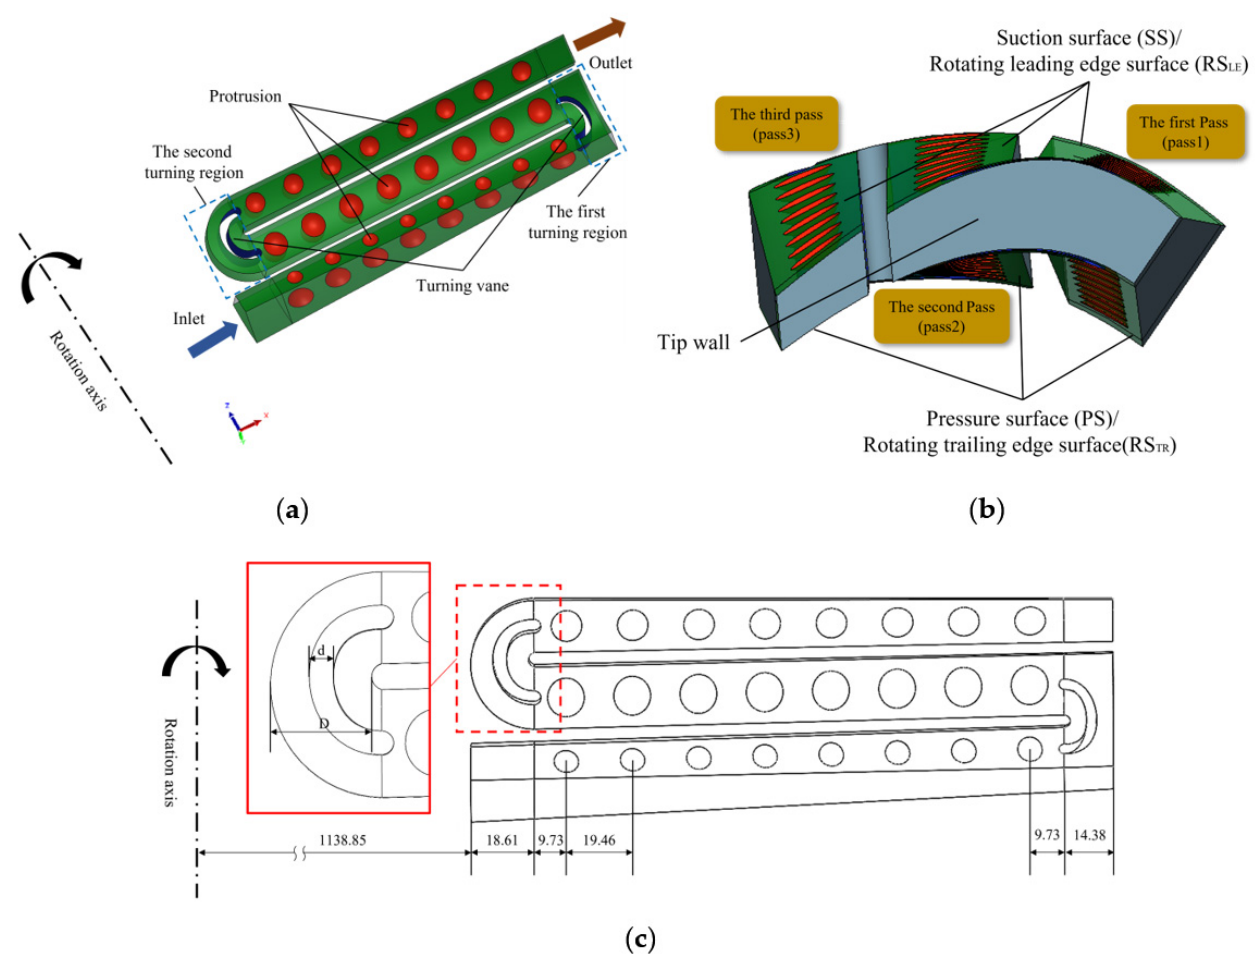
Figure 1. The serpentine channel model studied in this paper. ( a ) Three-dimensional model; ( b ) diagram from different direction; ( c ) structure and size of the channel.